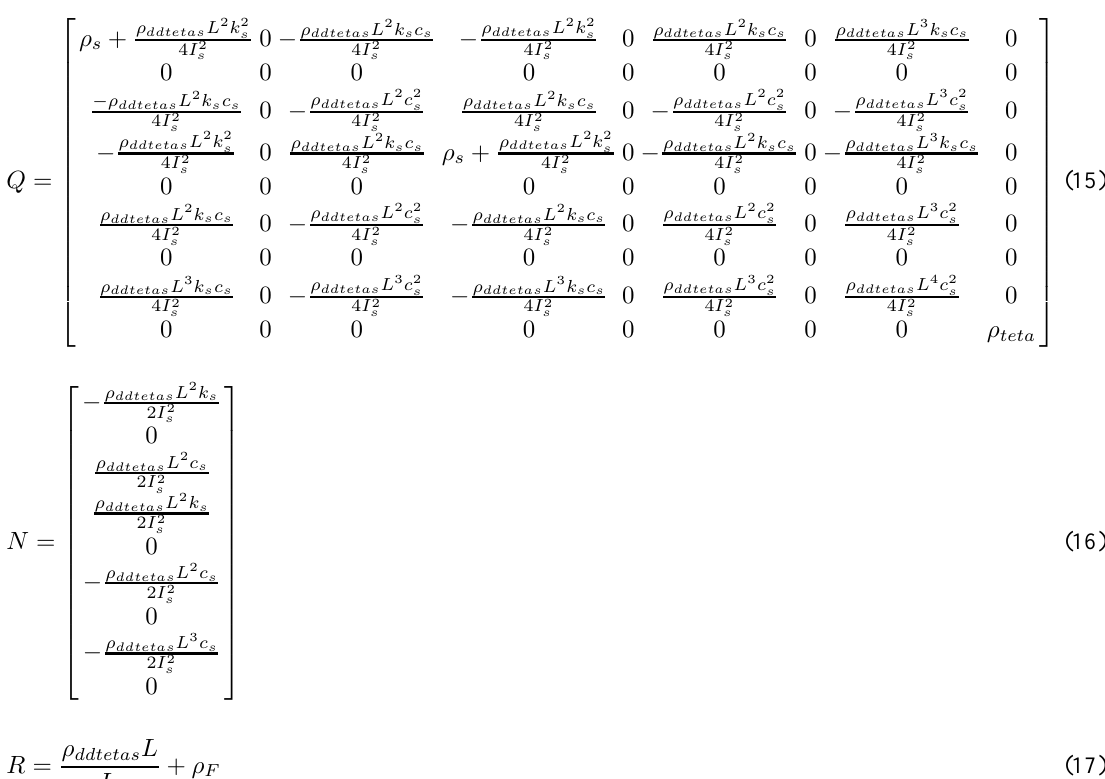
Fig. 5. Roll angle of passive suspension with passive